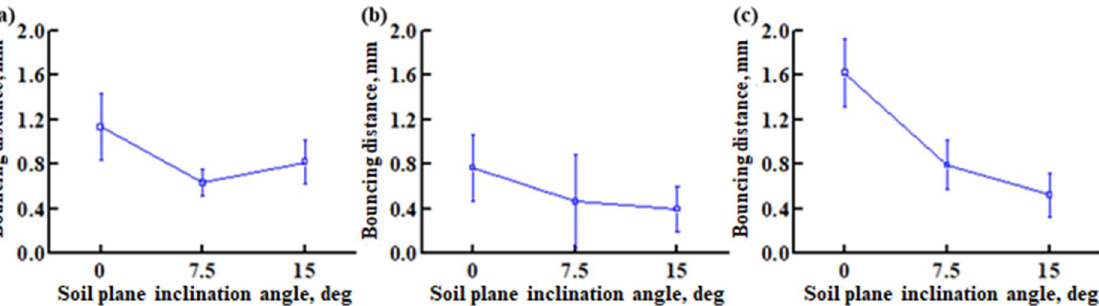
Figure 11. Test results of the relationship between bounce distance and soil plane inclination angle for ( a ) SN42, ( b ) JD17 and ( c ) ZD39.